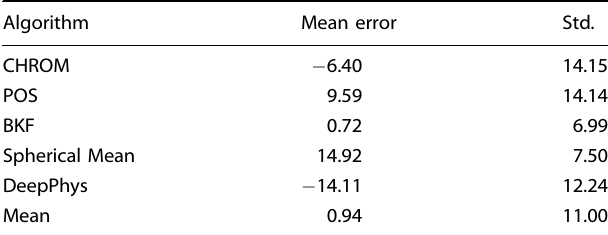
Fig. 3 Bland Altman plots for rPPG approaches compared to the Masimo. The plots show the agreement of the selected rPPG methods (BKF, Spherical Mean, DeepPhys, CHROM and POS) with the Masimo device readings for male subjects from India (yellow), female subjects from India (blue), male subjects from Sierra Leone (red) and female subjects from Sierra Leone (purple). Error bars and 95% con fi dence intervals are marked (in b.p.m.). Table 4. Bland Altman error statistics of rPPG methods compared to the Masimo (in